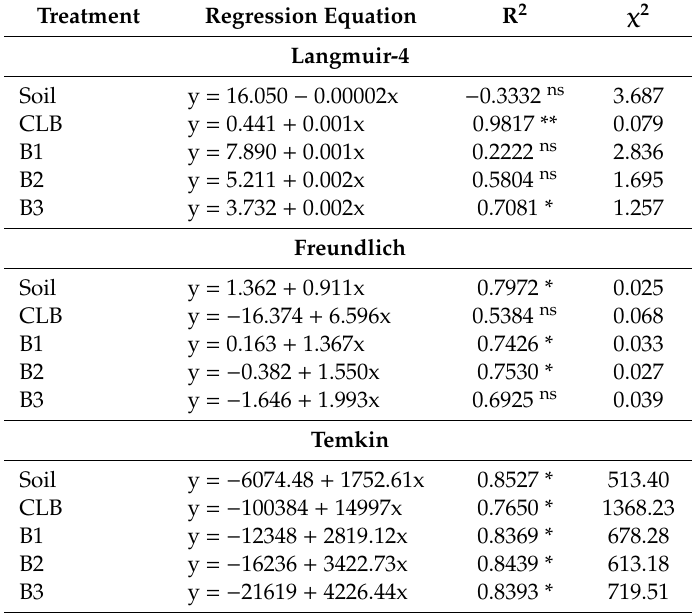
Table 18. Regression equations, Coe ffi cient of determination (R 2 ), and Chi-square analysis ( χ 2 ) for the fit of the Langmuir type 4, Freundlich, and Temkin isotherms to the potassium adsorption data of the